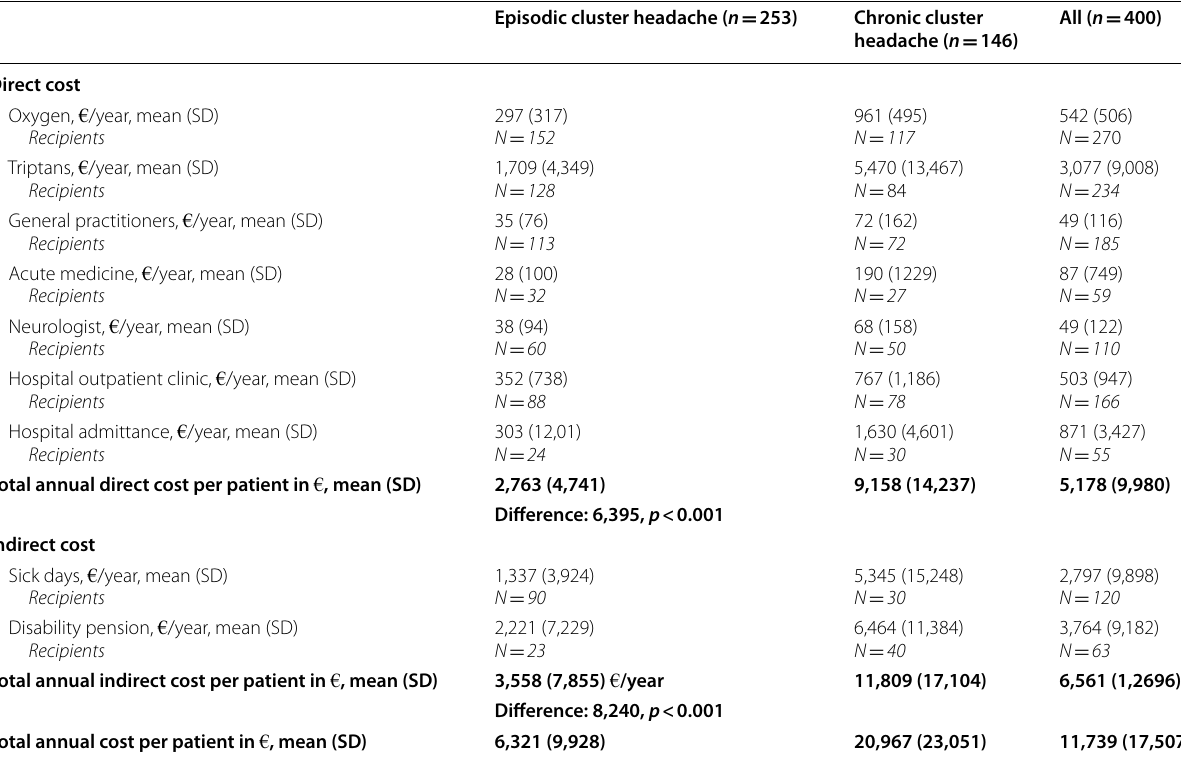
Table 4 Direct and indirect 1-year cost in € per patient with cluster headache